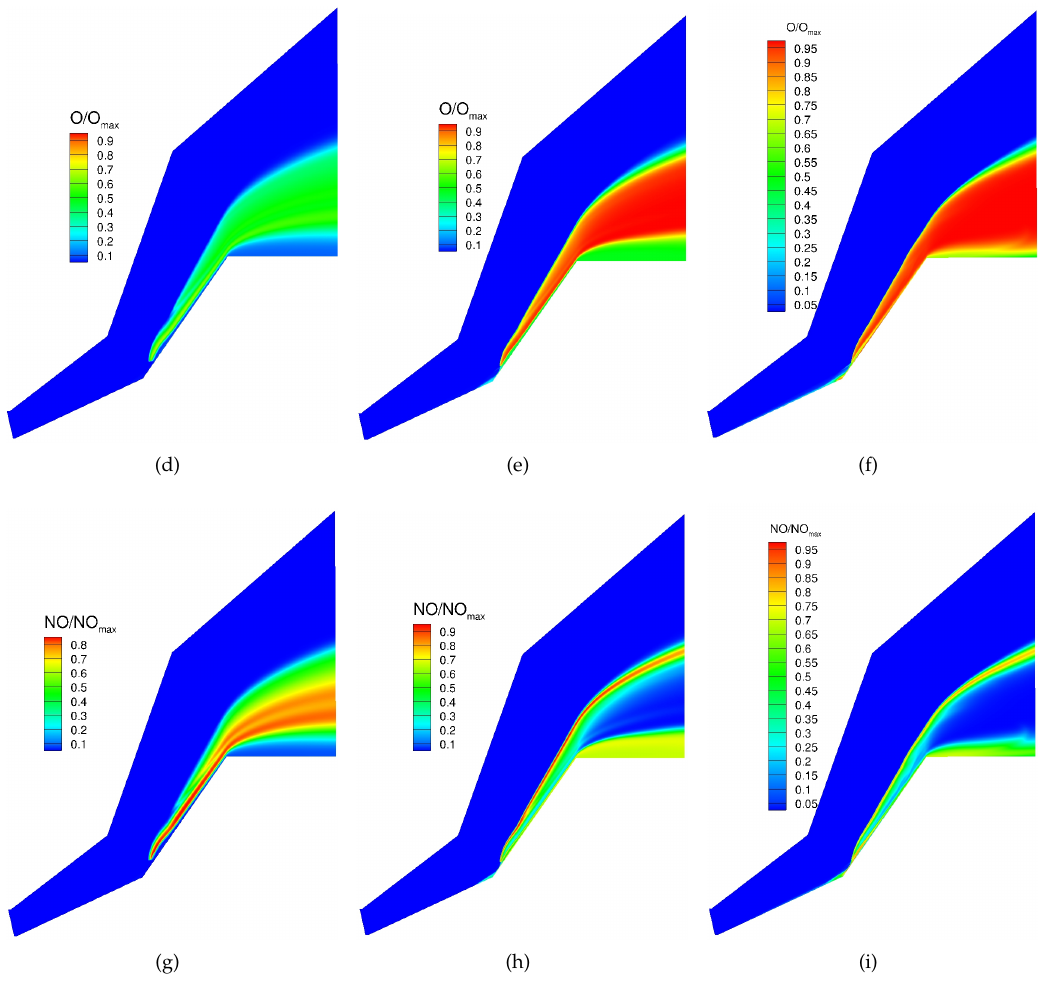
Figure 13. Species mass fractions, Table 1, (non-equilibrium Navier–Stokes model, non-catalytic). ( a ) Mass fraction of N for Run 2; ( b ) Mass fraction of N for Run 6; ( c ) Mass fraction of N for Run 4; ( d ) Mass fraction of O for Run 2; ( e ) Mass fraction of O for Run 6; ( f ) Mass fraction of O for Run 4; ( g ) Mass fraction of NO for Run 2; ( h ) Mass fraction of NO for Run 6; ( i ) Mass fraction of NO for Run